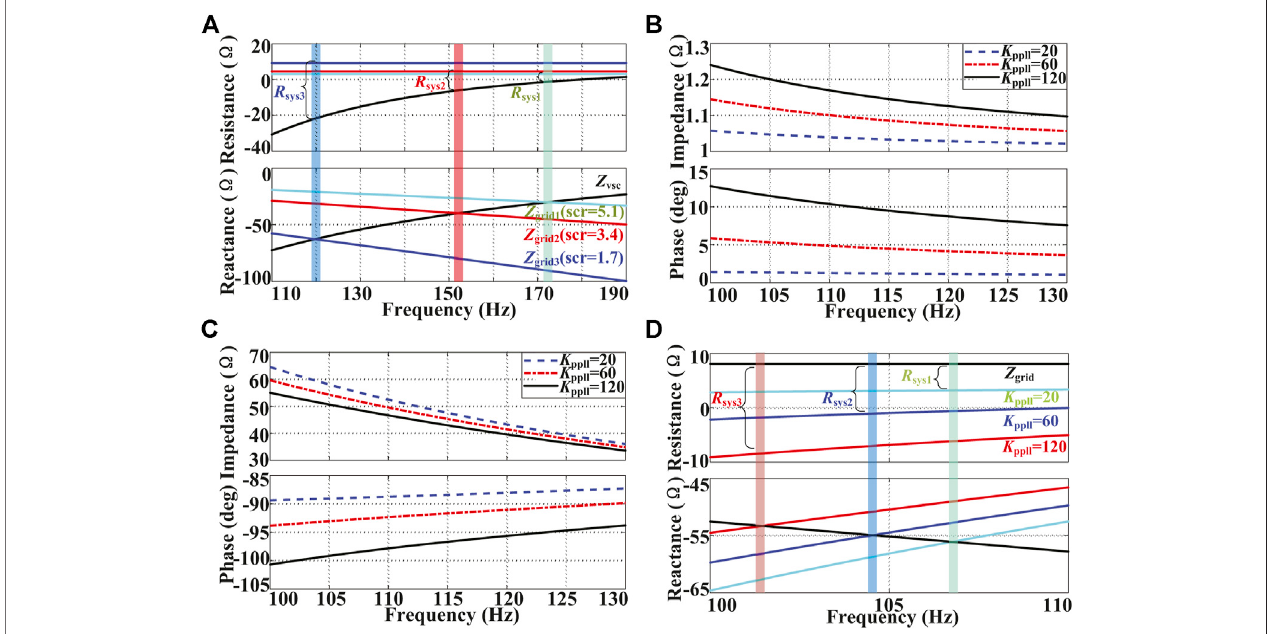
FIGURE 6 | Impact of SCR on the impedance-frequency curves. (A) Z vsc ( s ) and Z grid ( s ) and impact of K ppll on the impedance-frequency curves. (B) Z pll ( s ) ; (C) Z vsc ( s ) ; and (D) Z vsc ( s ) and Z grid ( s )